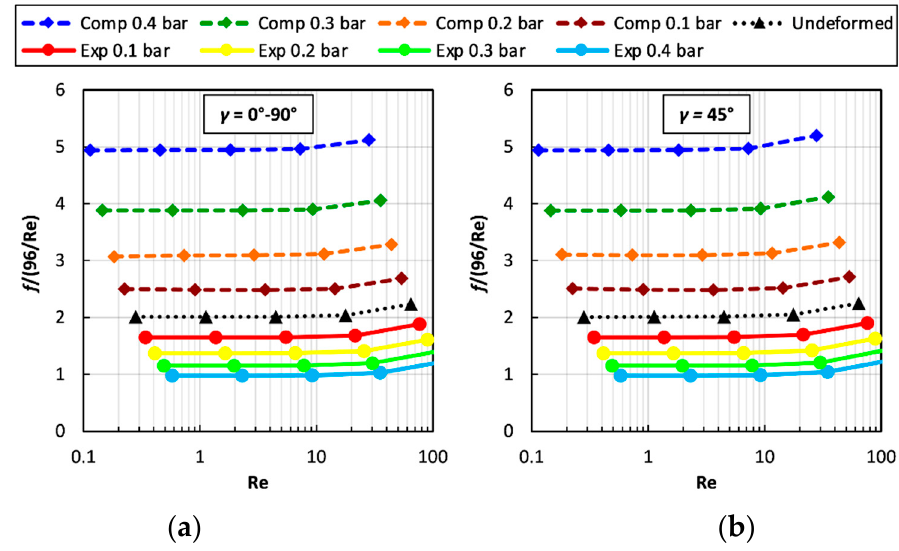
Figure 7. Normalized Darcy friction coefficient ( F ratio) as a function of Re for P/H = 8, different values of the trans-membrane pressure TMP and two values of the flow attack angle γ . ( a ) γ = 0° or 90°; ( b ) γ = 45°.